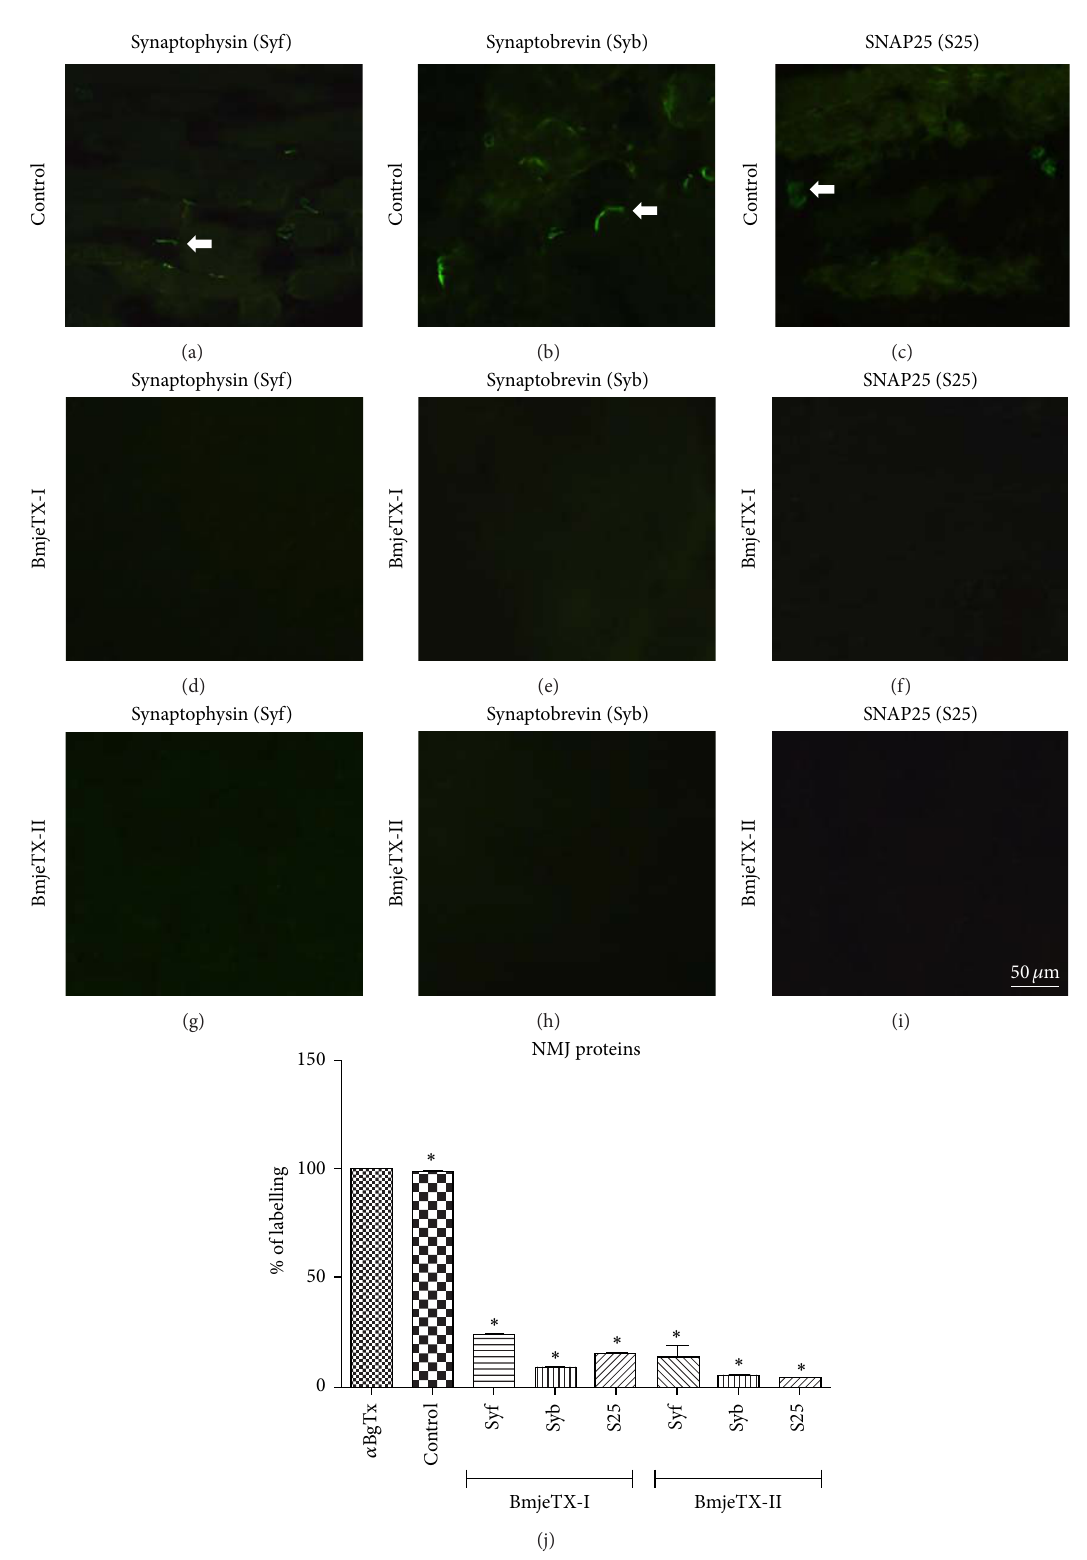
Figure 6: Immunofluorescence for synaptophysin, Syf (a, d, g), synaptobrevin, Syb (b, e, h), and SNAP25, S25 (c, f, i) in neuromuscular junction (NMJ) of chick biventer cervicis. In controls ((a)–(c)) all proteins were expressed indicating active presynaptic machinery. However, in BmjeTX-I-treated ((d)–(f)) and BmjeTX-II-treated (g)–(i) preparations no immunolabelling was detected indicating inactivity of the presynaptic machinery. (j) Percentage of Syf, Syb, and S25 protein showed 100% expression in control preparations and represented as a single control bar, whereas a remarkable reduction was observed for BmjeTX-I- and BmjeTX-II-treated samples. 𝛼 -Bungarotoxin ( 𝛼 BgTx) was used to indicate the ACh receptor. Data were expressed as mean ± SD ( ∗ 𝑝 < 0.0001 relative to control), one-way ANOVA plus Bonferroni posttest ( 𝑛 = 4 per